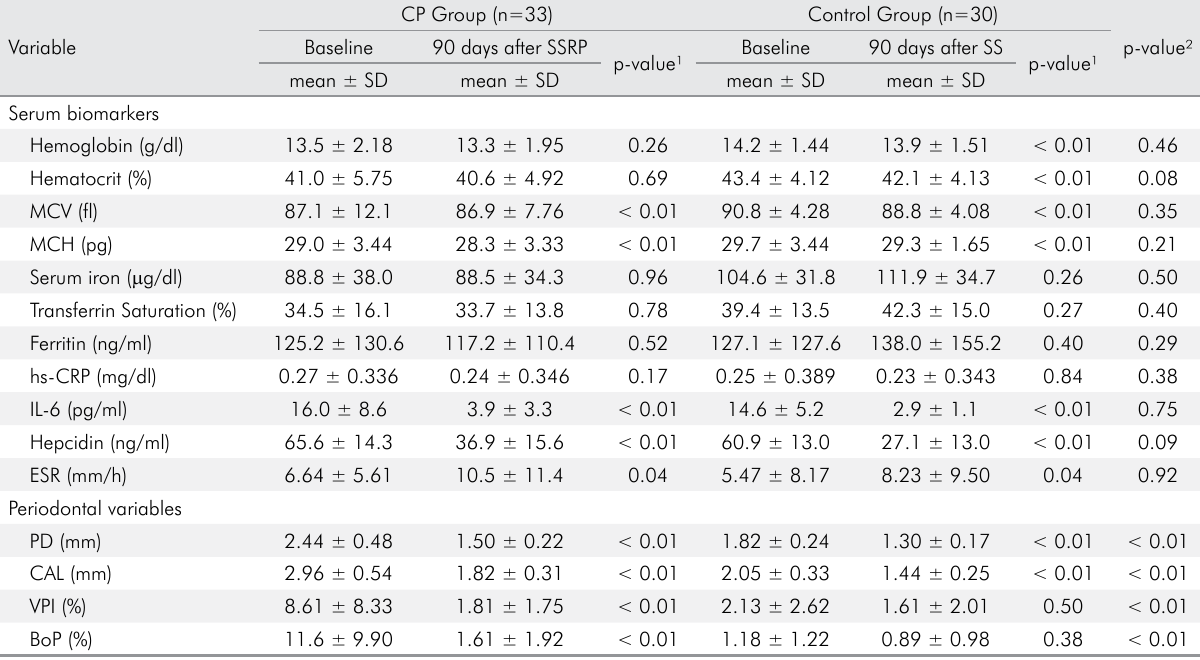
Table 2. Distribution of serum biomarkers and periodontal variables at baseline and 90 days after nonsurgical periodontal therapy and comparative analysis between